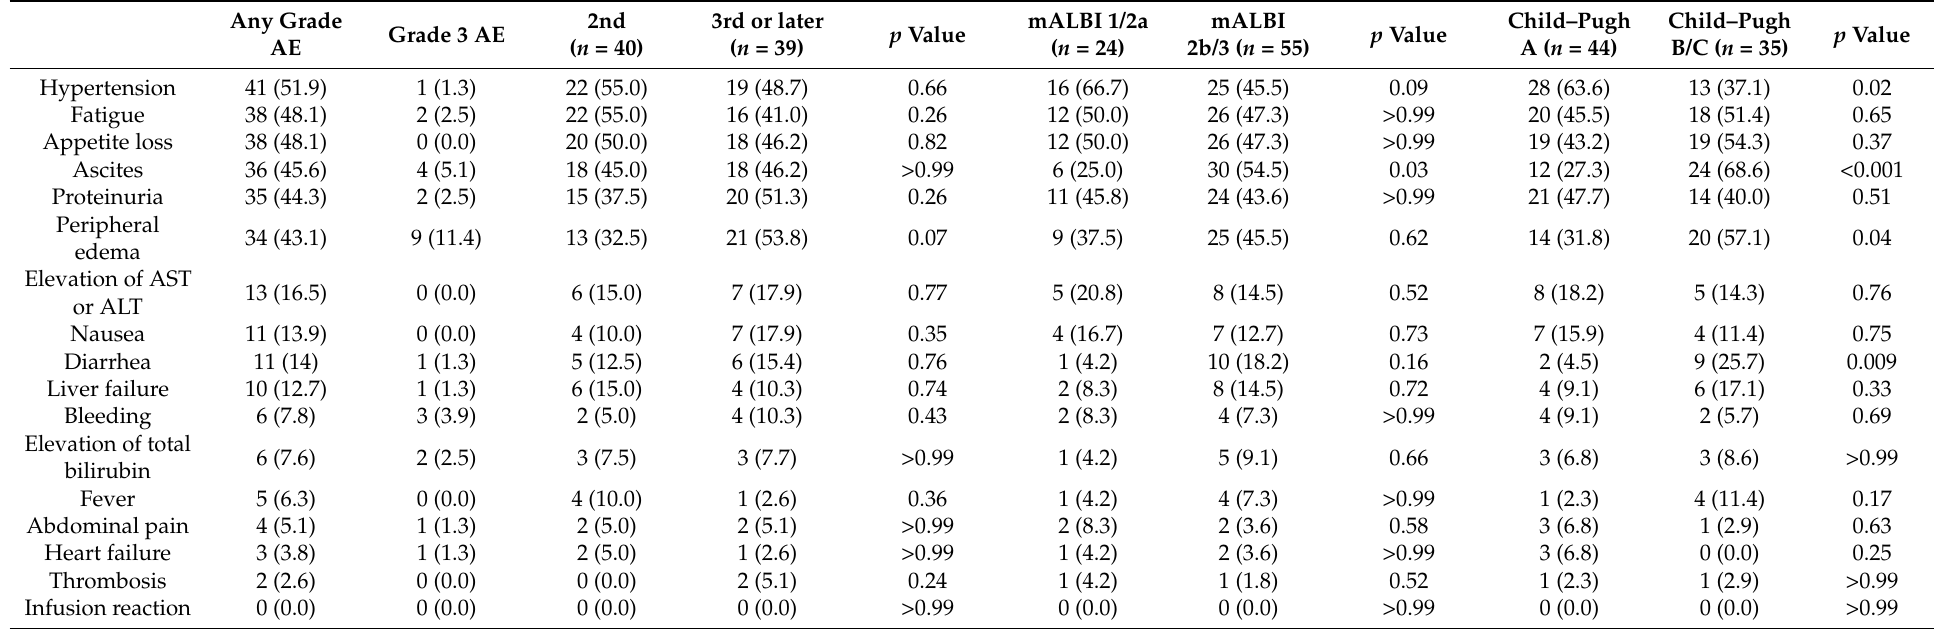
Table 3. Adverse events during ramucirumab